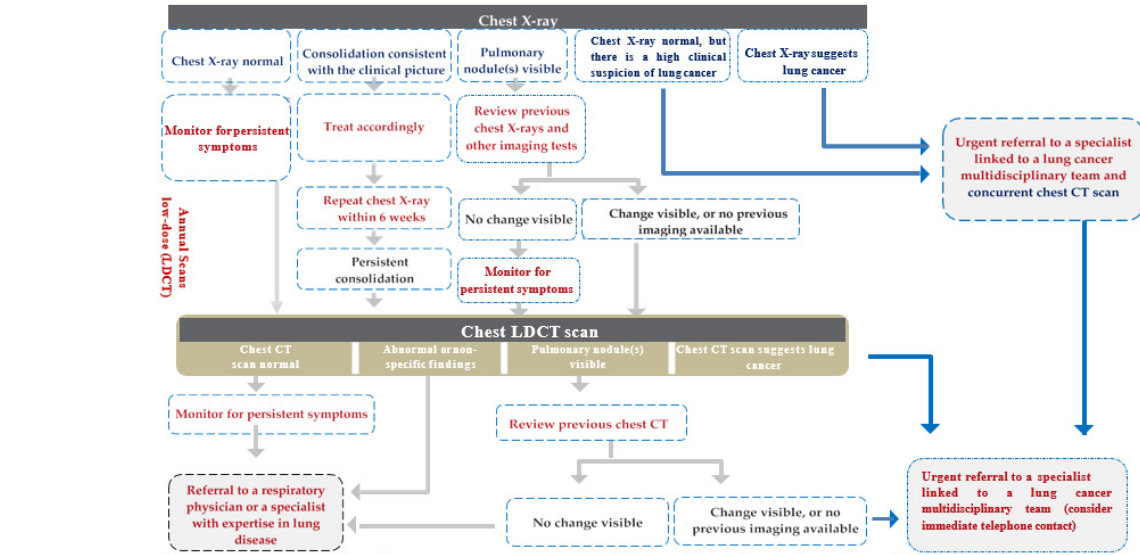
Figure 1. Recommended referral pathway for patient with suspected lung cancer. CT: computed tomography; LDCT: low-dose computed tomography.